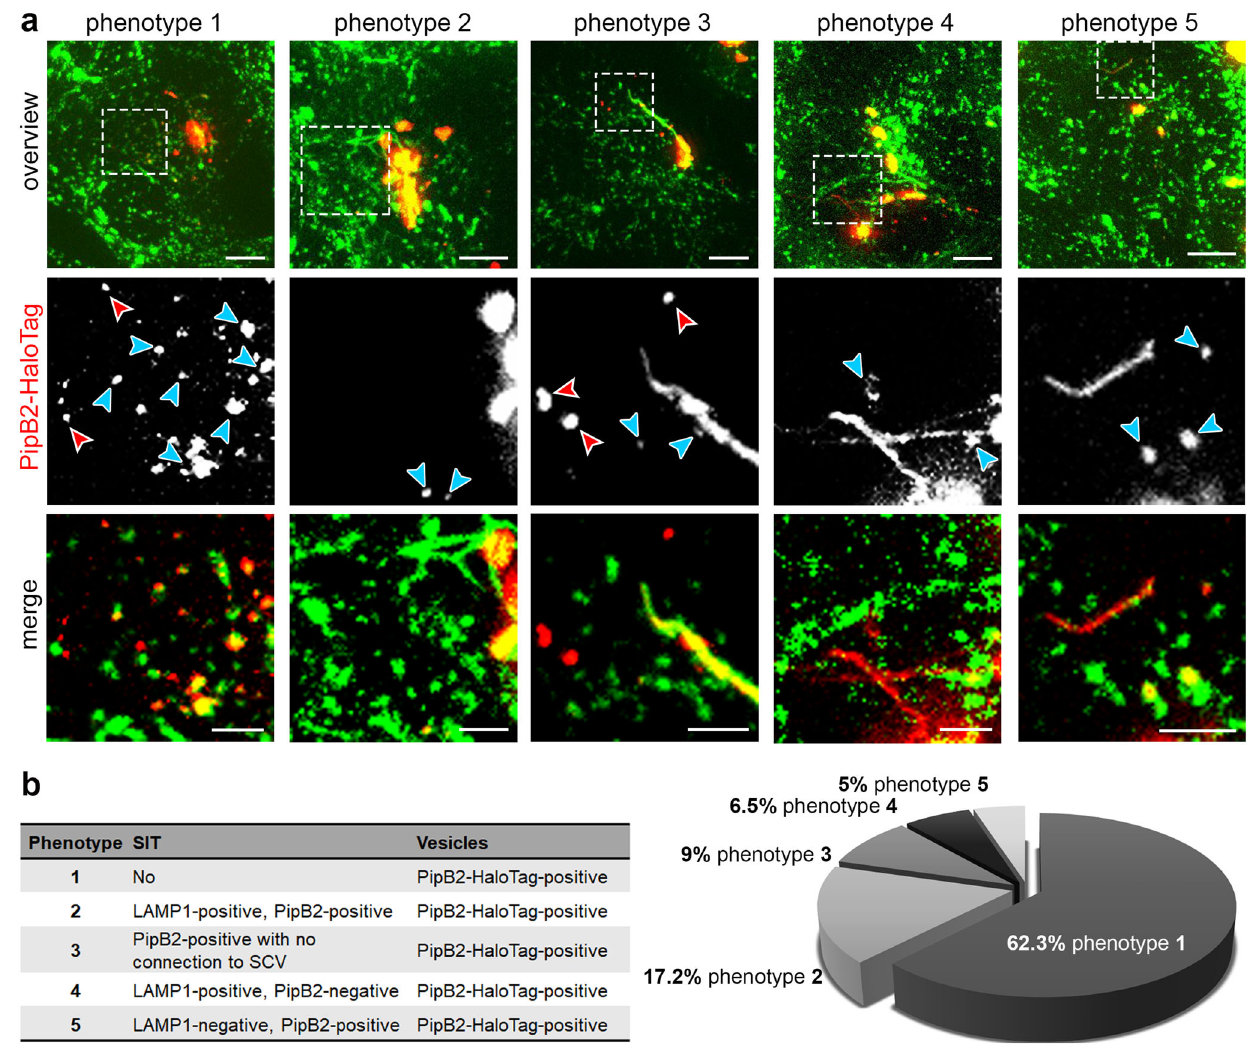
Fig. 6 | Distribution of PipB2-HaloTag in the early phase of infection. HeLa LAMP1-GFP cells were infected with STM pipB2 mutant strain expressing pipB2 :: - HaloTag::HA. a LCI was performed directly after cells were stained with 1 µ M HTL- TMRat3.5hp.i.for30min.ForinfectedcellswithPipB2-HaloTag-positivevesicles, thephenotypesofPipB2-HaloTaglocalizationonvesiclesandSITweredetermined. Blue arrowheads indicate vesicles double-positive for LAMP1-GFP and HTL-TMR-